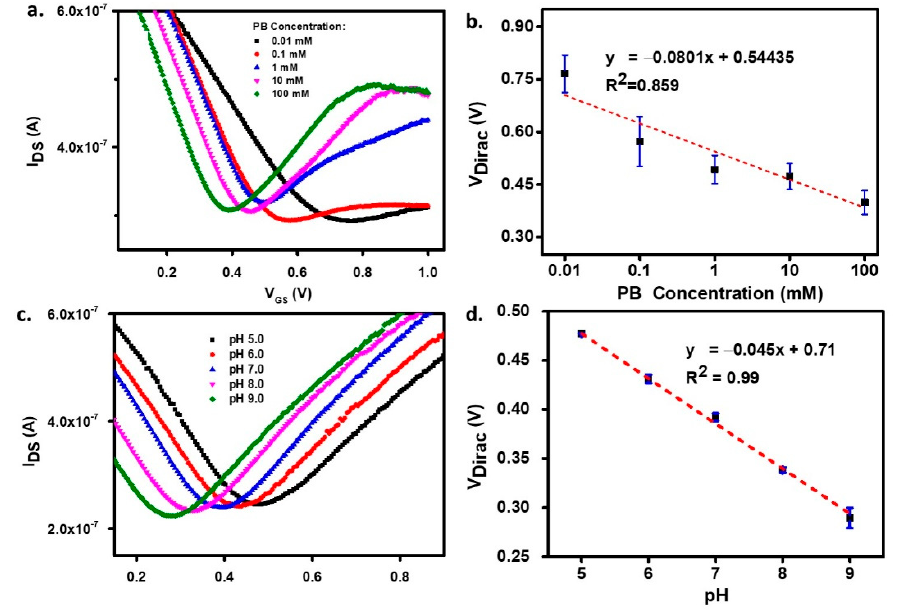
Figure 3. ( a ) I DS V GS characteristic, and ( b ) extracted Dirac voltage point as the function of different phosphate buffer (PB) concentrations, ( c ) I DS V GS characteristic, and ( d ) extracted Dirac voltage point as the function of varying pH.